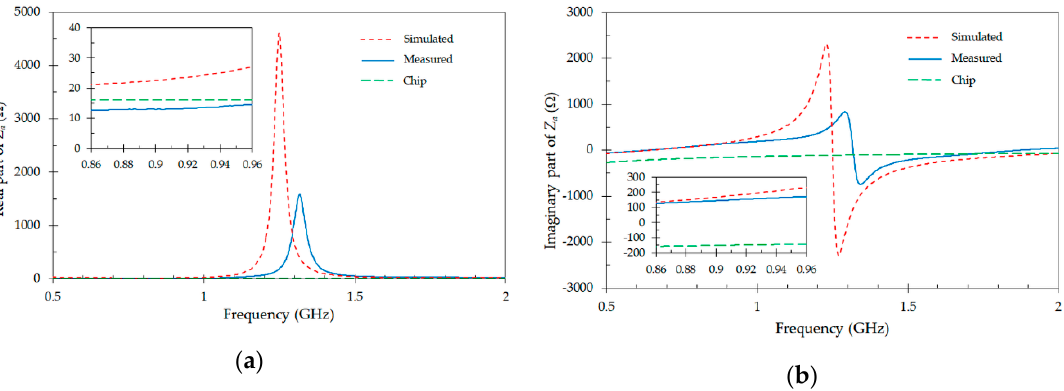
Figure 8. Simulated and measured impedance of the proposed tag antenna. ( a ) Real part of the impedance; ( b ) imaginary part of the impedance. Green dashed line denotes the impedance of the chip (NXP UCODE G2XL).